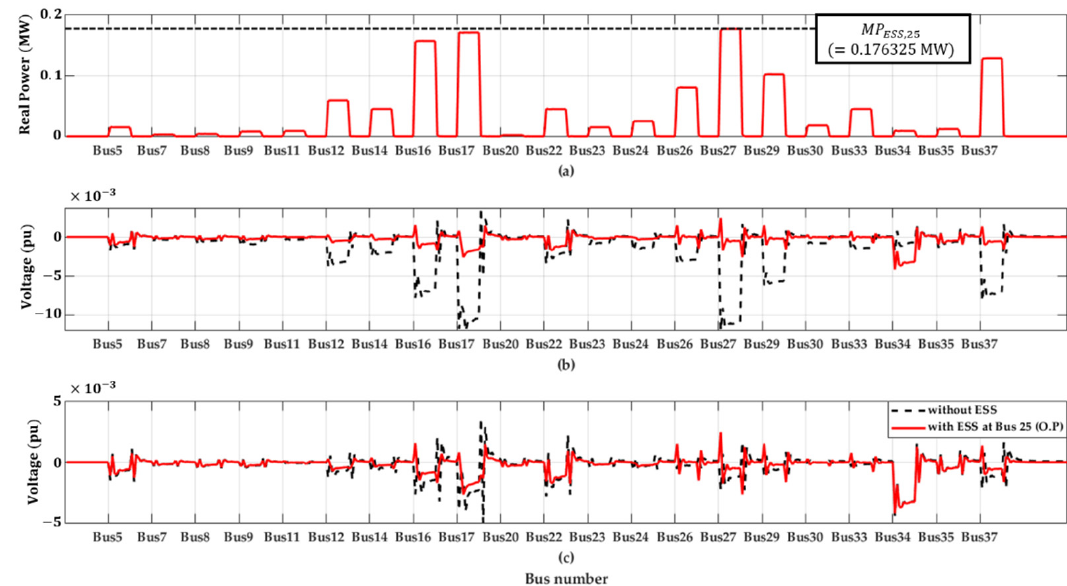
Figure 4. With ESS at optimal placements and sizing: ( a ) real power response of ESS, ( b ) voltage deviation change at bus 25, and ( c ) voltage deviation changes at bus 34 during the VMS operation. O.P, optimal placement.